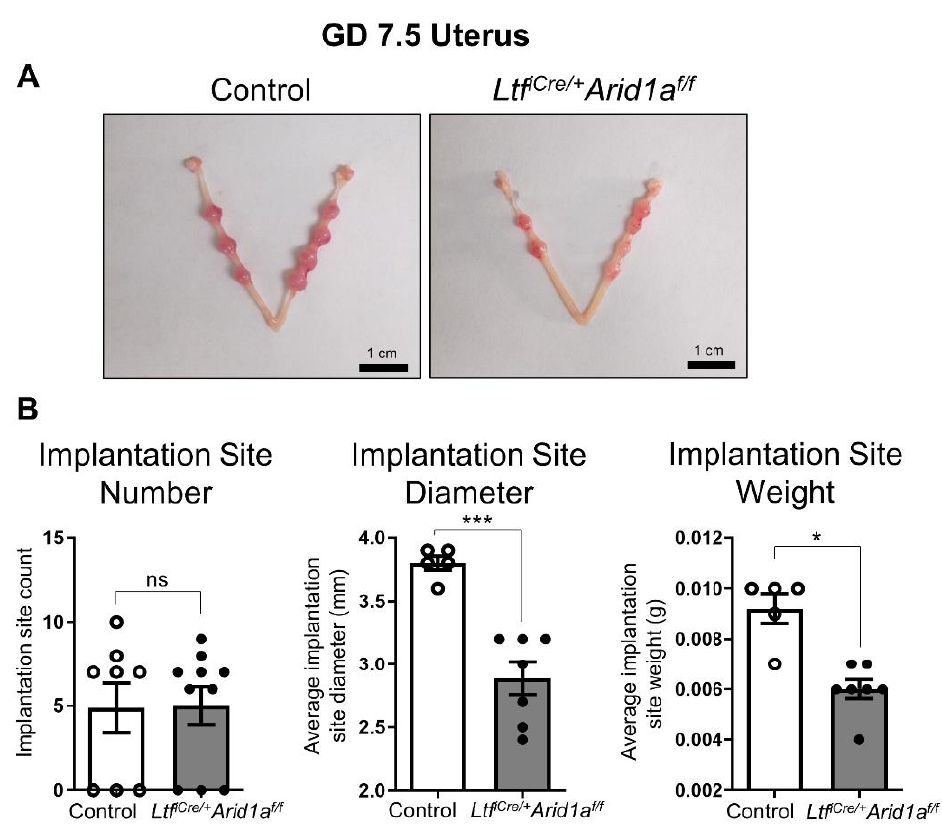
Figure 1. Deletion of endometrial epithelial Arid1a in mice causes diminished implantation site size and uNK cell numbers at GD 7.5. ( A ) Implantation sites were grossly visible in both control ( n = 8) and Ltf iCre/+ Arid1a f/f ( n = 10) uteri at GD 7.5, appearing smaller in Ltf iCre/+ Arid1a f/f uteri. ( B ) Implantation site number (left) as counted based on gross morphology was similar between control ( n = 8, empty bar) and Ltf iCre/+ Arid1a f/f ( n = 10, grey bar) uteri at GD 7.5, but the average implantation site diameter (middle) and weight (right) were significantly decreased in Ltf iCre/+ Arid1a f/f ( n = 7, grey bar) uteri compared to controls ( n = 5, empty bar). The graphs represent the mean ± SEM. * p < 0.05; ***, p < 0.001; ns, p > 0.05. Abbreviations: Arid1a , AT-rich interaction domain 1A; GD, gestation day; Ltf , lactoferrin; uNK, uterine natural killer.